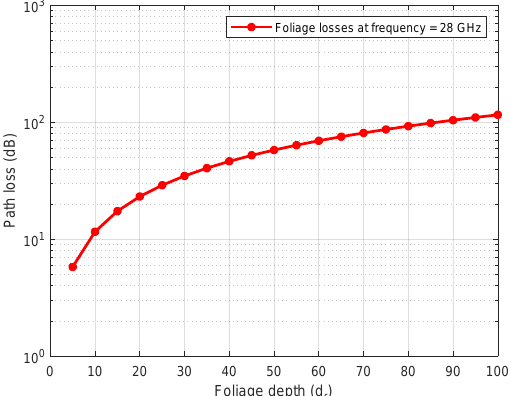
Figure 9. Path losses calculated through ITU developed Weissberger